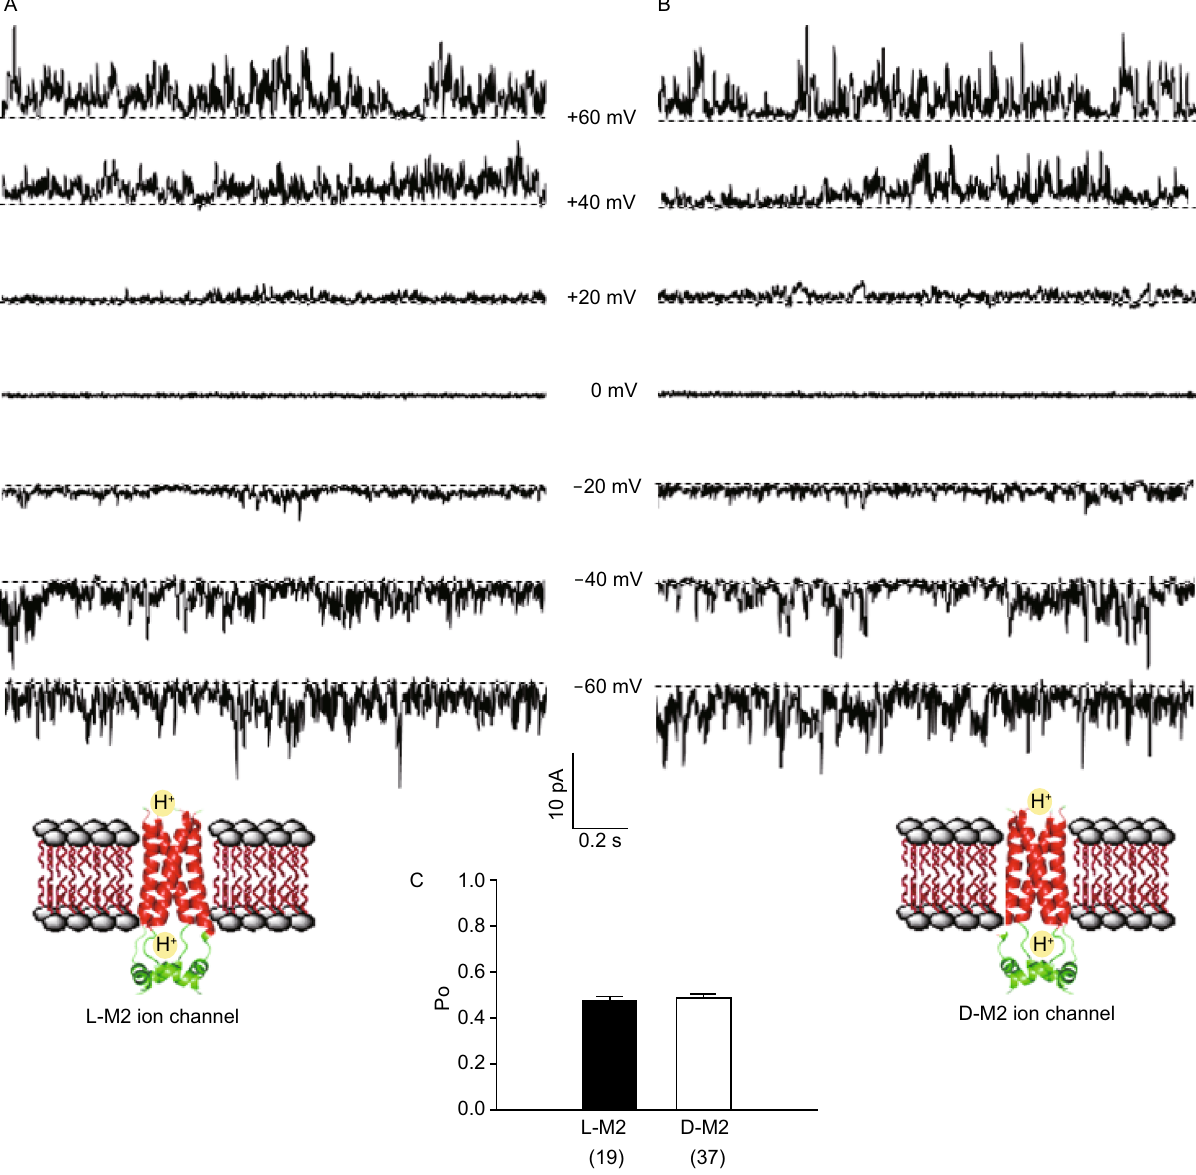
Figure 2. Single-channel currents of chemical synthetic . (A) L-M2 and (B) D-M2 ion channels after reconstitution in POPC/POPG (3:1) lipid vesicles; (C) the open probability of L-/D- M2 channels at +60 mV. The traces were recorded at various membrane potentials; the inhibitory effect of achiral inhibitor amantadine (20 μ mol/L) on (D) L-M2 and (E) D-M2; chiral inhibitor R-rimantadine (20 μ mol/L) on (F) L-M2 and (G) D-M2. Dotted line: